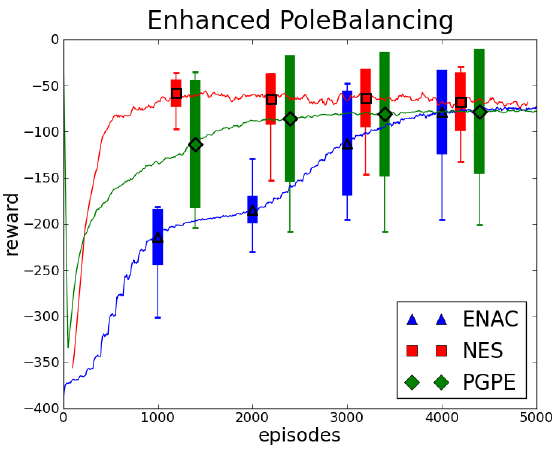
Figure 9. PGPE and NES on the object grasping